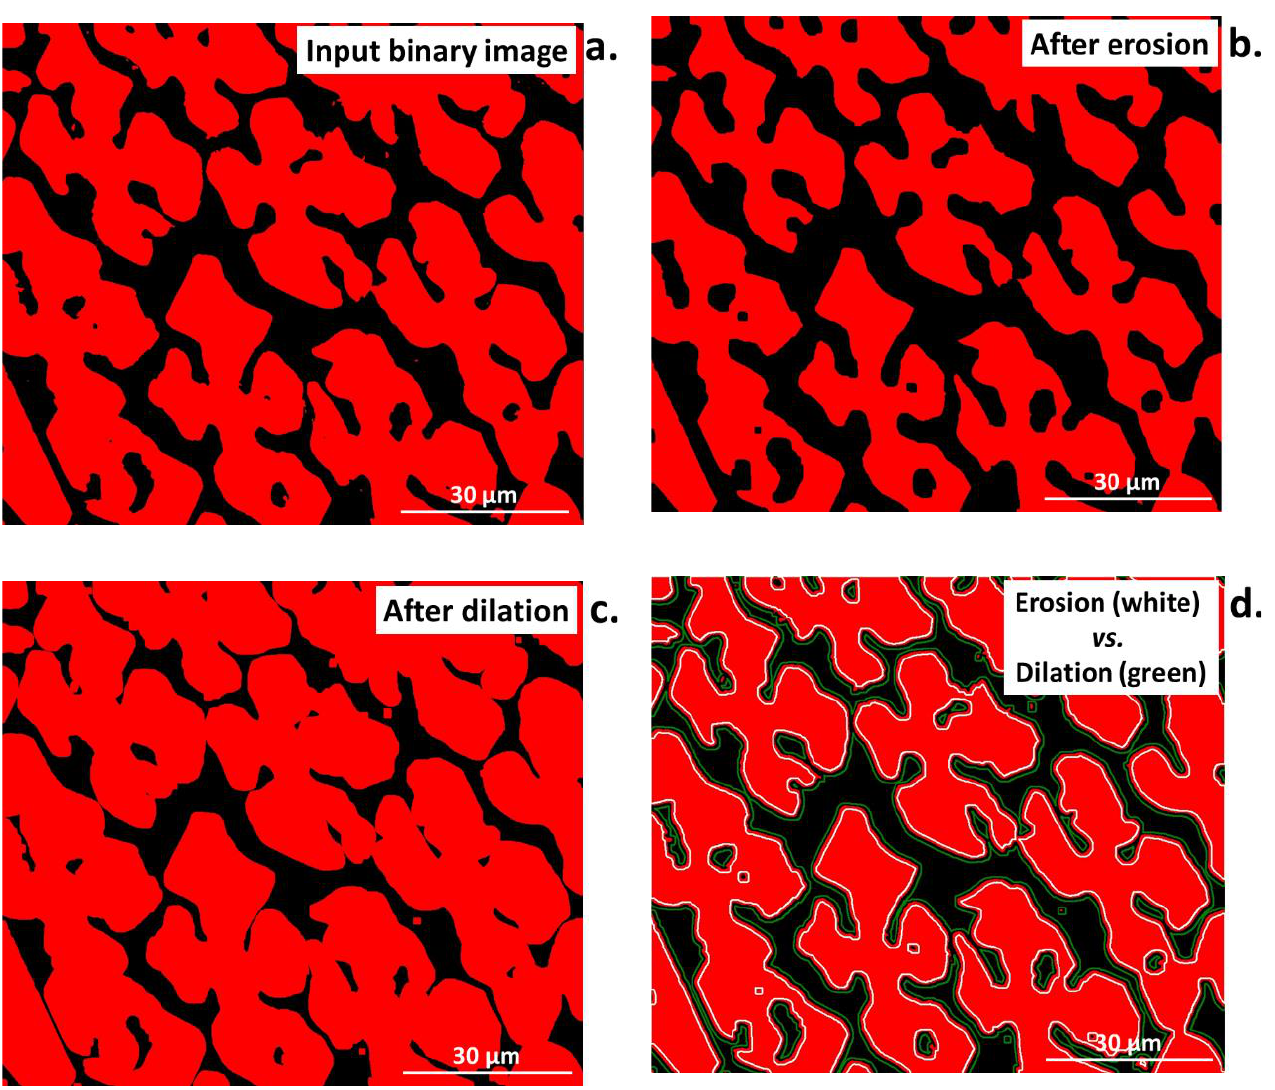
Figure 7. Comparison of the ( a ) input image after Otsu binarization to images after ( b ) erosion, ( c ) dilation, and ( d ) erosion (white lines) and dilation (green lines) superimposed on the input binary image.